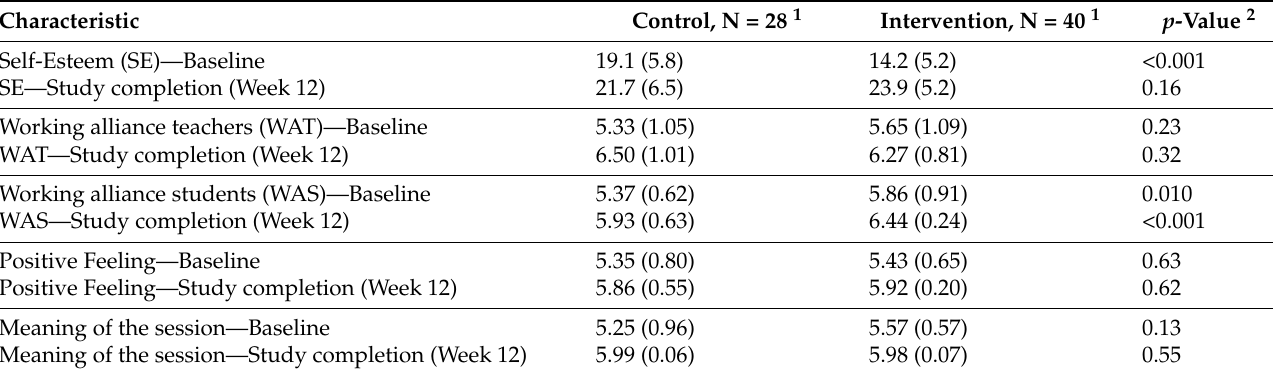
Table 3. Means and standard deviations of all measures for all groups (intervention/control) at baseline and Study